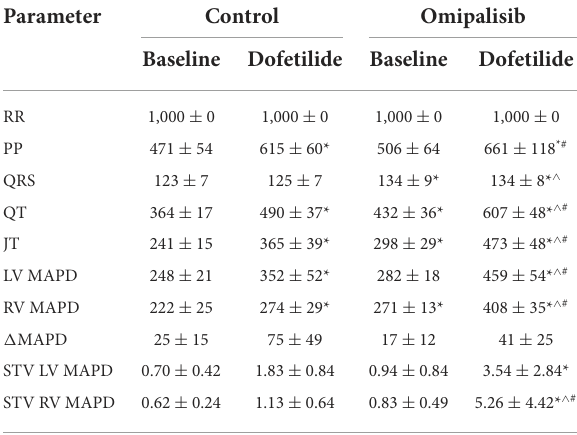
TABLE 3 Electrophysiological parameters of anesthetized dogs ( n twice a